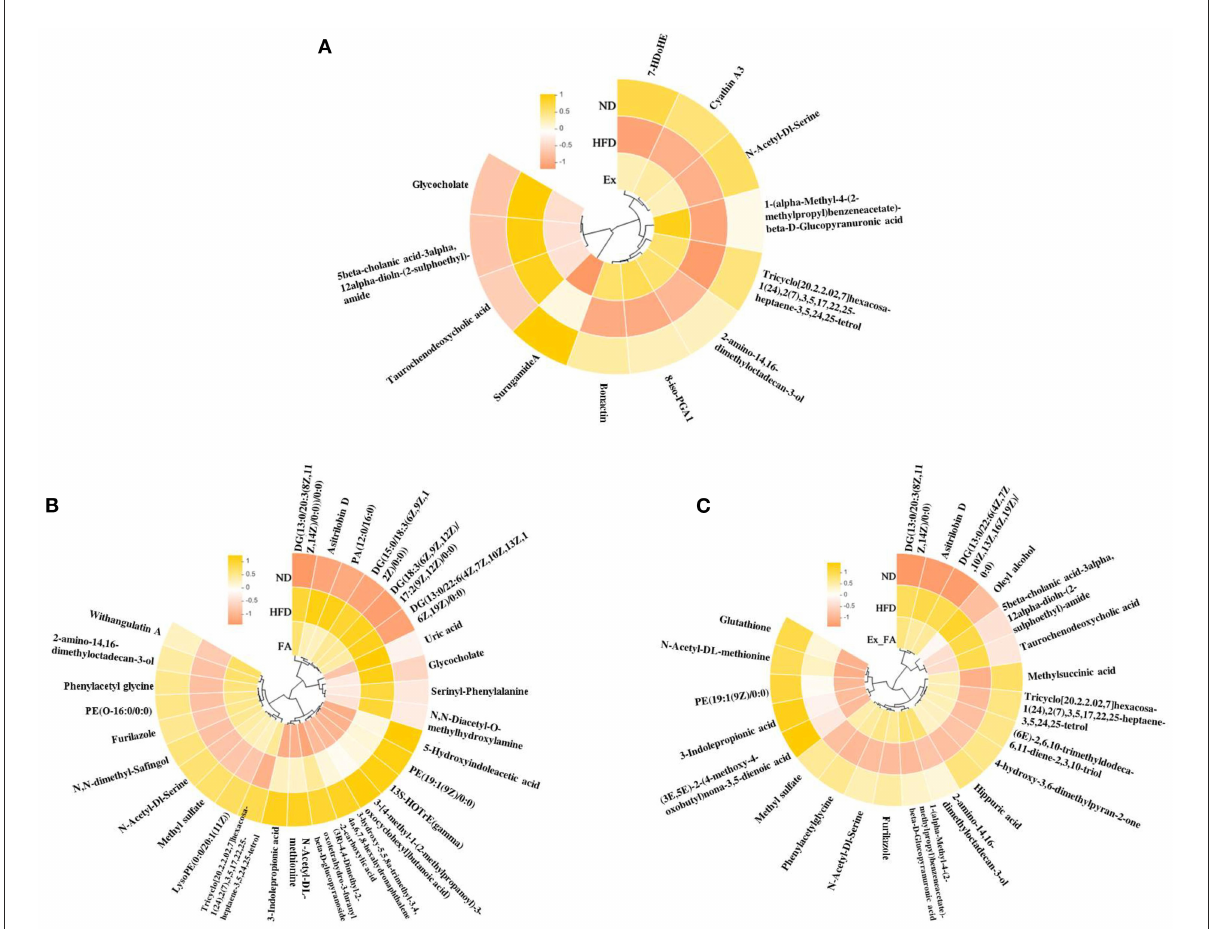
FIGURE8 Heatmaps of the metabolites. (A) The common metabolites of ND, HFD, and Ex. (B) The common metabolites of ND, HFD, and FA. (C) The common metabolites of ND, HFD, and Ex-FA. ND, normal diet group (control); HFD, high-fat diet group (model); Ex, high-fat diet with exercise; FA, high-fat diet with ferulic acid; Ex-FA, high-fat diet with exercise and ferulic